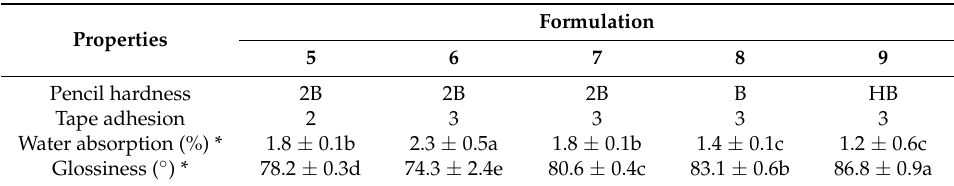
Table 4. The effect of PETMP content on coating properties.